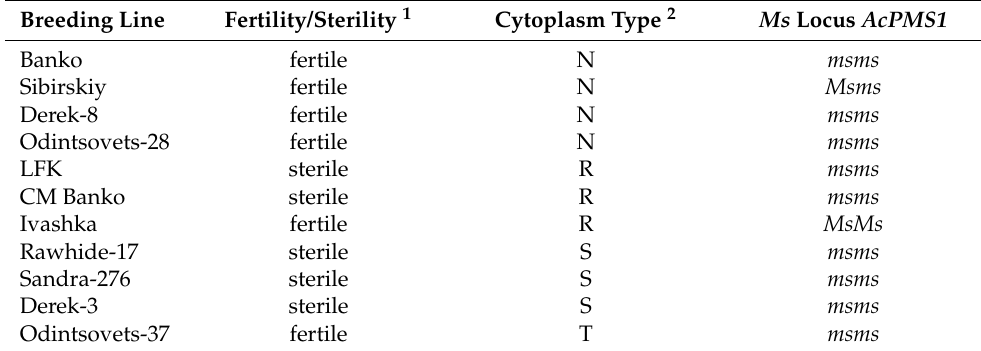
Table 4. Comparison of pollen fertility, cytoplasm type and Ms locus